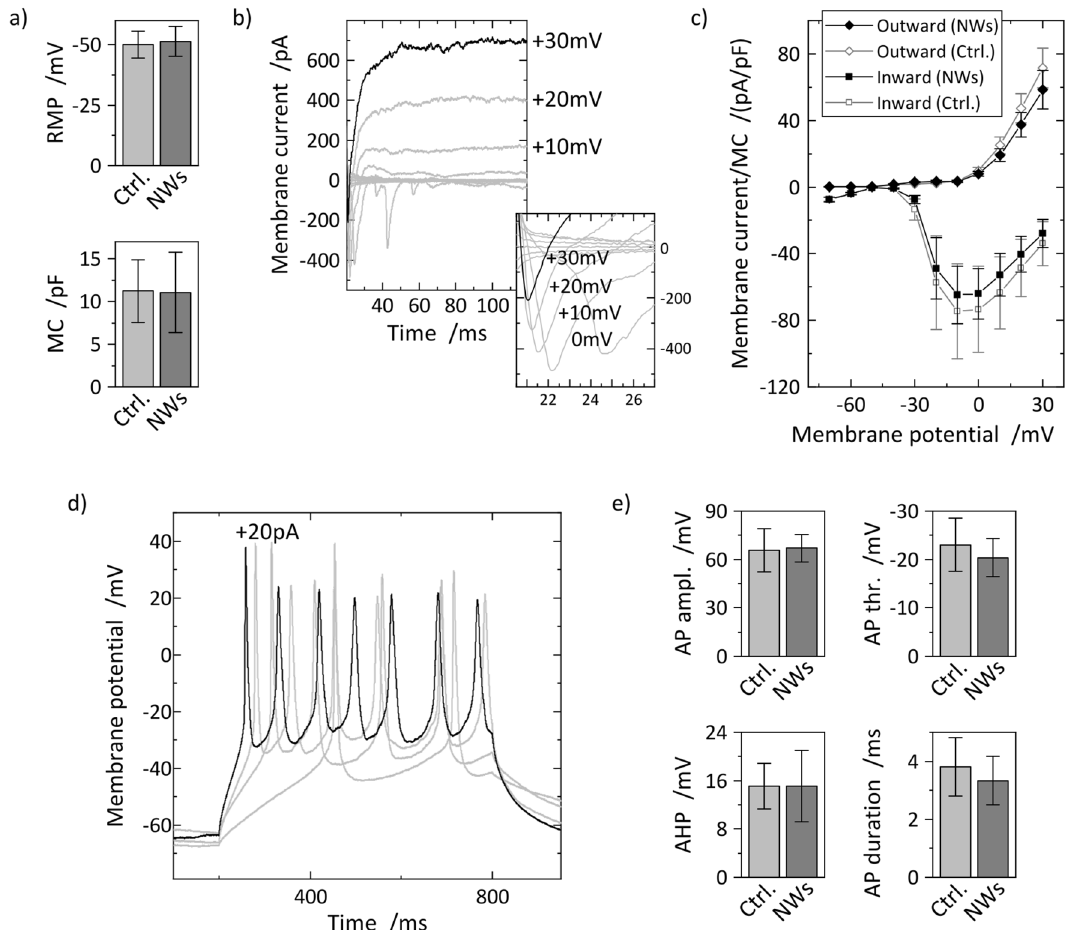
Figure 4. Electrophysiological characterization of human iPSC-derived neurons on NW substrates compared to control. ( a ) Quantification of passive membrane properties: resting membrane potential (RMP) and membrane capacitance (MC) of neurons on NWs and control. ( b ) Exemplary traces of early-inward (negative peaks) and late-outward currents (constant positive currents) of neurons cultured on NW substrates recorded in voltage-clamp mode with voltage steps of 10 mV from –70 to +30 mV. Inset: Zoom into early-inward currents. ( c ) Peak inward/outward currents normalized by MC plotted against membrane potential compared to control. ( d ) Typical action potential (AP) traces recorded from neurons on NWs. APs were stimulated by current injections from 5 to 20 pA in 5 pA steps. The firing frequency increases with increasing amplitude of the stimulus. ( e ) Analysis of the AP kinetics: AP amplitude from threshold to peak (AP ampl.), AP threshold (AP thr.), after hyperpolarization (AHP, overshoot after AP), and full width half maximum of the APs (AP duration). n(NWs) = 7, n(control) = 10, error bars are SDs, no statistical significances (Mann-Whitney U test: all P > 0.05, cf. Table S2 in the supporting